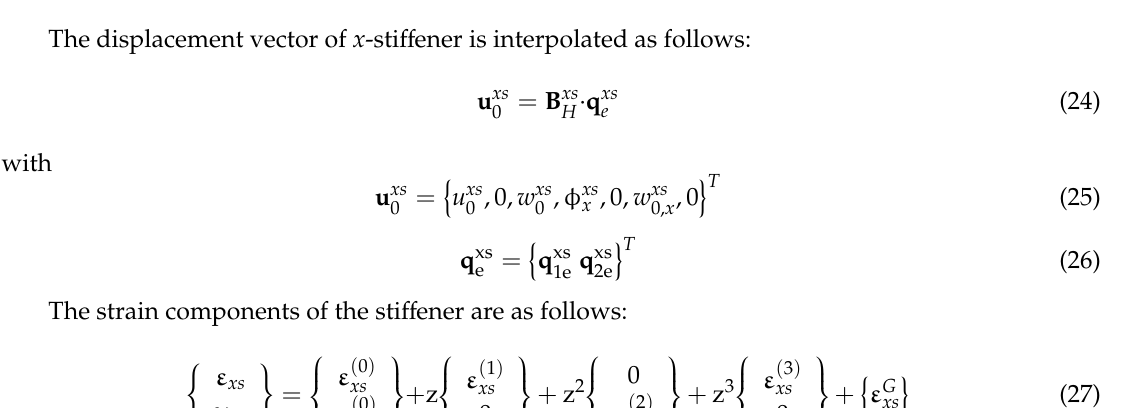
Figure 2. Plate element and stiffener element.